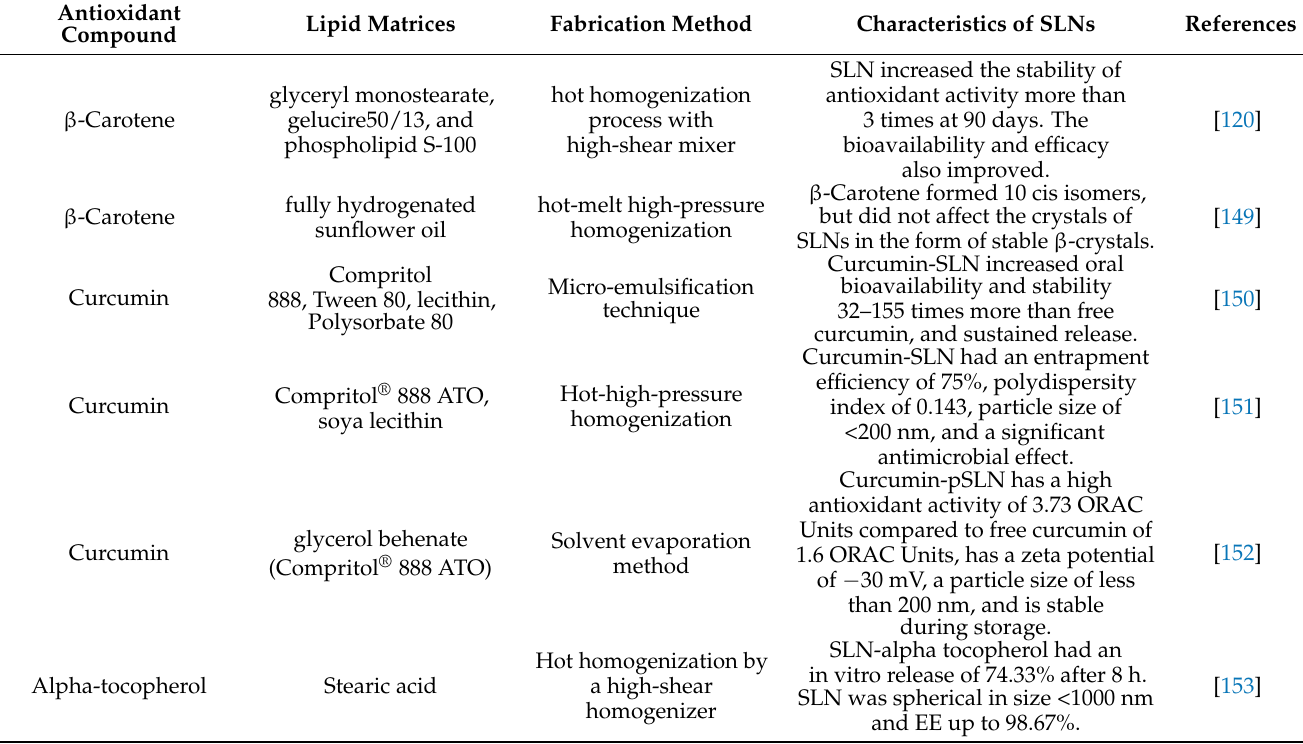
Table 5. Application of SLNs for the Encapsulation of Non-Polar Antioxidant